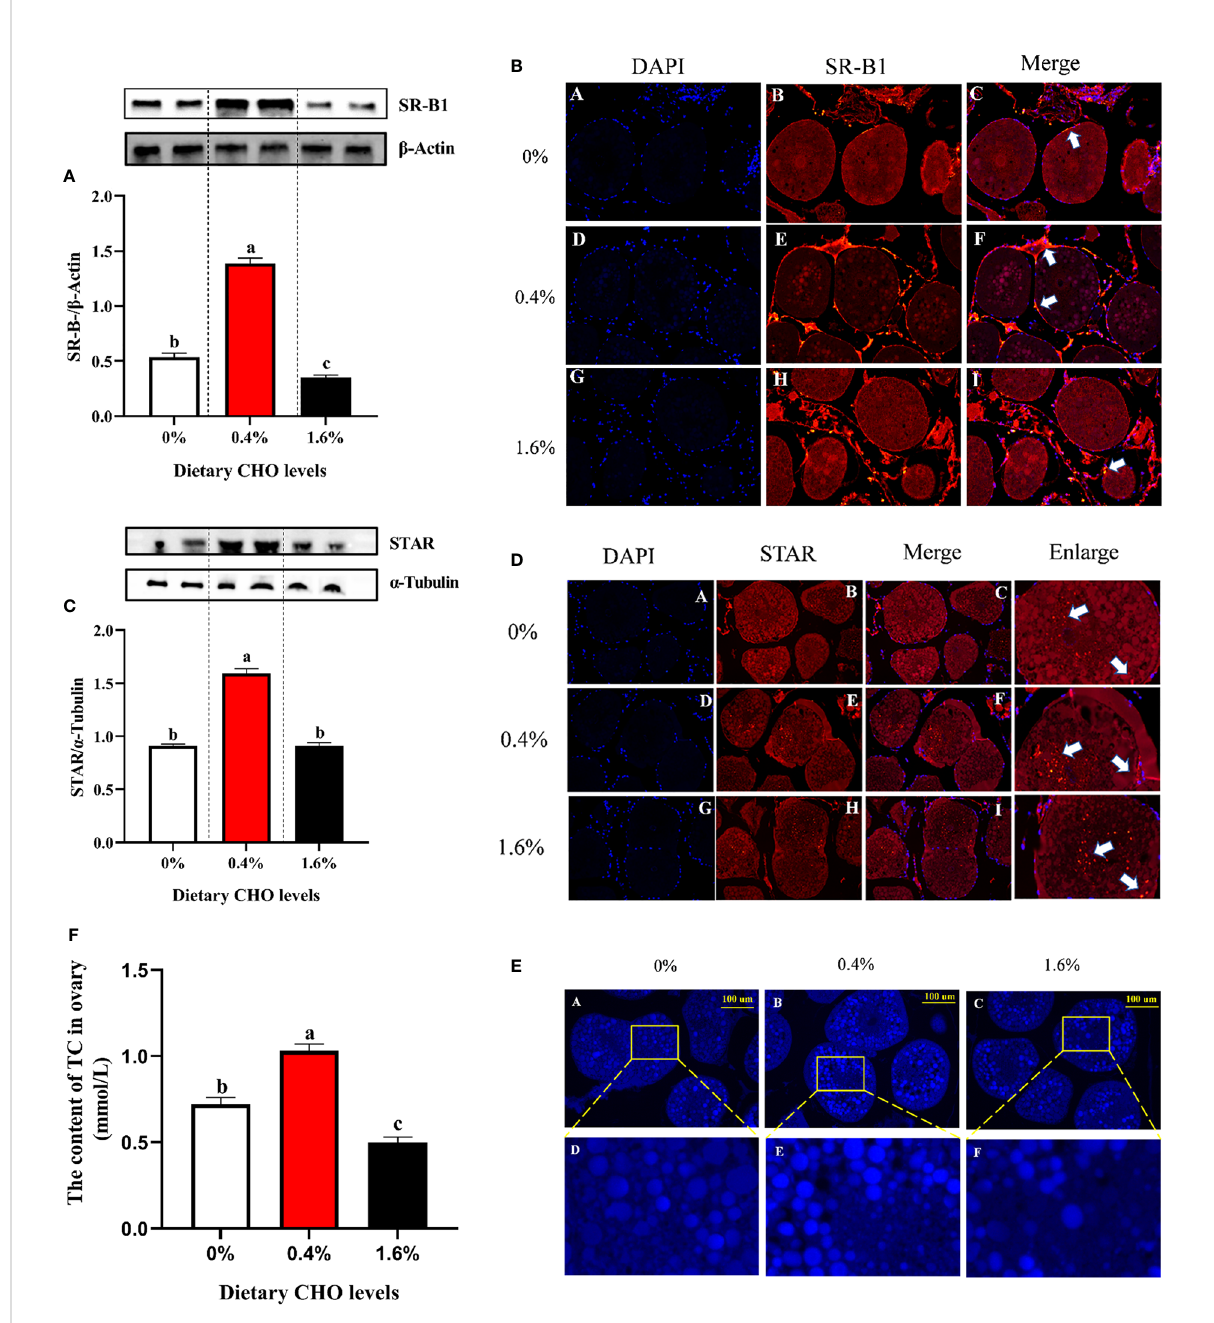
FIGURE 5 Effects of dietary CHO on (A) the protein expression of SR-B1 in ovary; (B) the immuno fl uorescence of SR-B1 in ovary (blue: nucleus; red: SR- B1); (C) the protein expression of STAR in ovary; (D) the immuno fl uorescence of STAR in ovary (blue: nucleus; red: STAR). The content of ovary CHO after crabs was fed diets with different CHO levels. (E) Representative confocal microscopic image of ovarian CHO stained by FILIPIN (blue), photomicrographs (200×) and scale bar (100 m m); (F) The content of TC in ovary. The values are the Means ± SEM ( n = 4). Different letters indicate signi fi cant differences ( P <